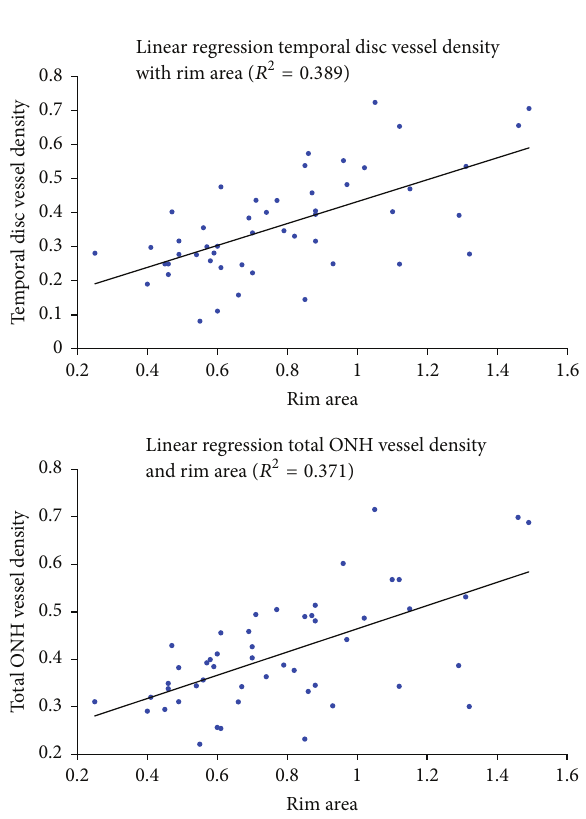
Figure 2: Linear regression analysis for temporal disc vessel density, total ONH vessel density, and rim